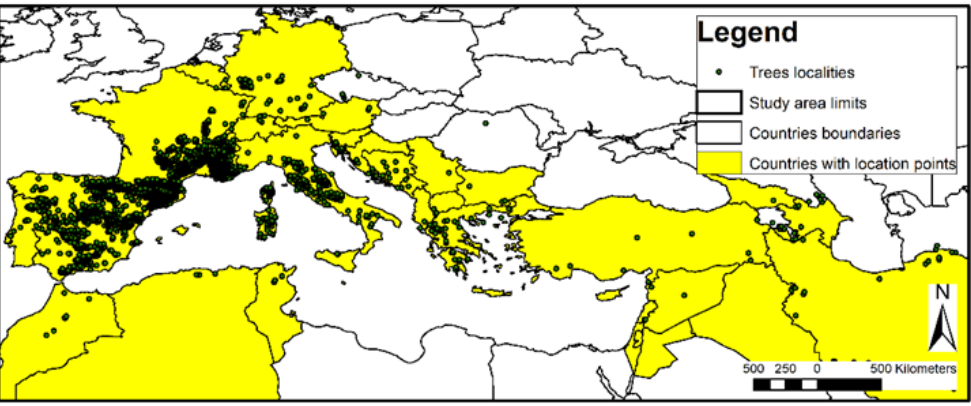
Figure 2. Study area: distribution area and presence points of the Montpellier Maple.